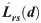
Number of pairwise association between species with similar (dark grey) or different (light grey) dispersal modes, shade tolerance and life-forms found using the L^rs(d) and K^mmrs(d) analyses for positive and negative associations in BNC.In L^rs(d), positive and negative associations indicate spatial attraction and repulsion, respectively. In the K^mmrs(d) analysis, positive values indicate attraction among species at similar ages, and negative values indicate attraction among species at opposite ages.